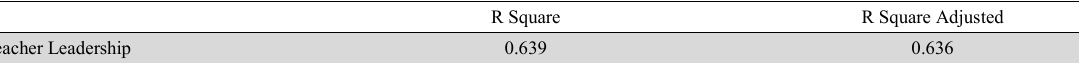
Summary coefficient of determination